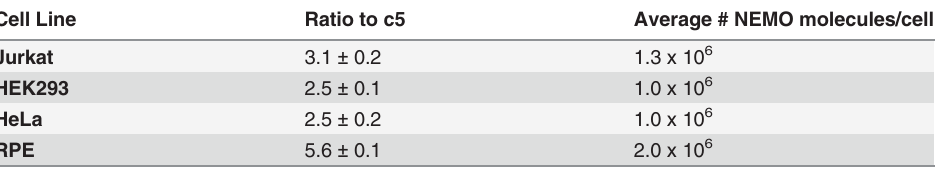
Table 1. Average number of NEMO molecules per cell of various cell lines compared to